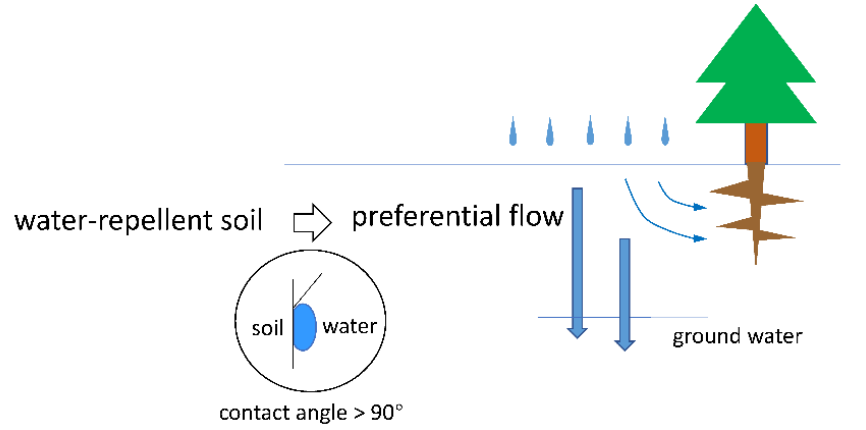
Figure 11. Preferential flow in water-repellent